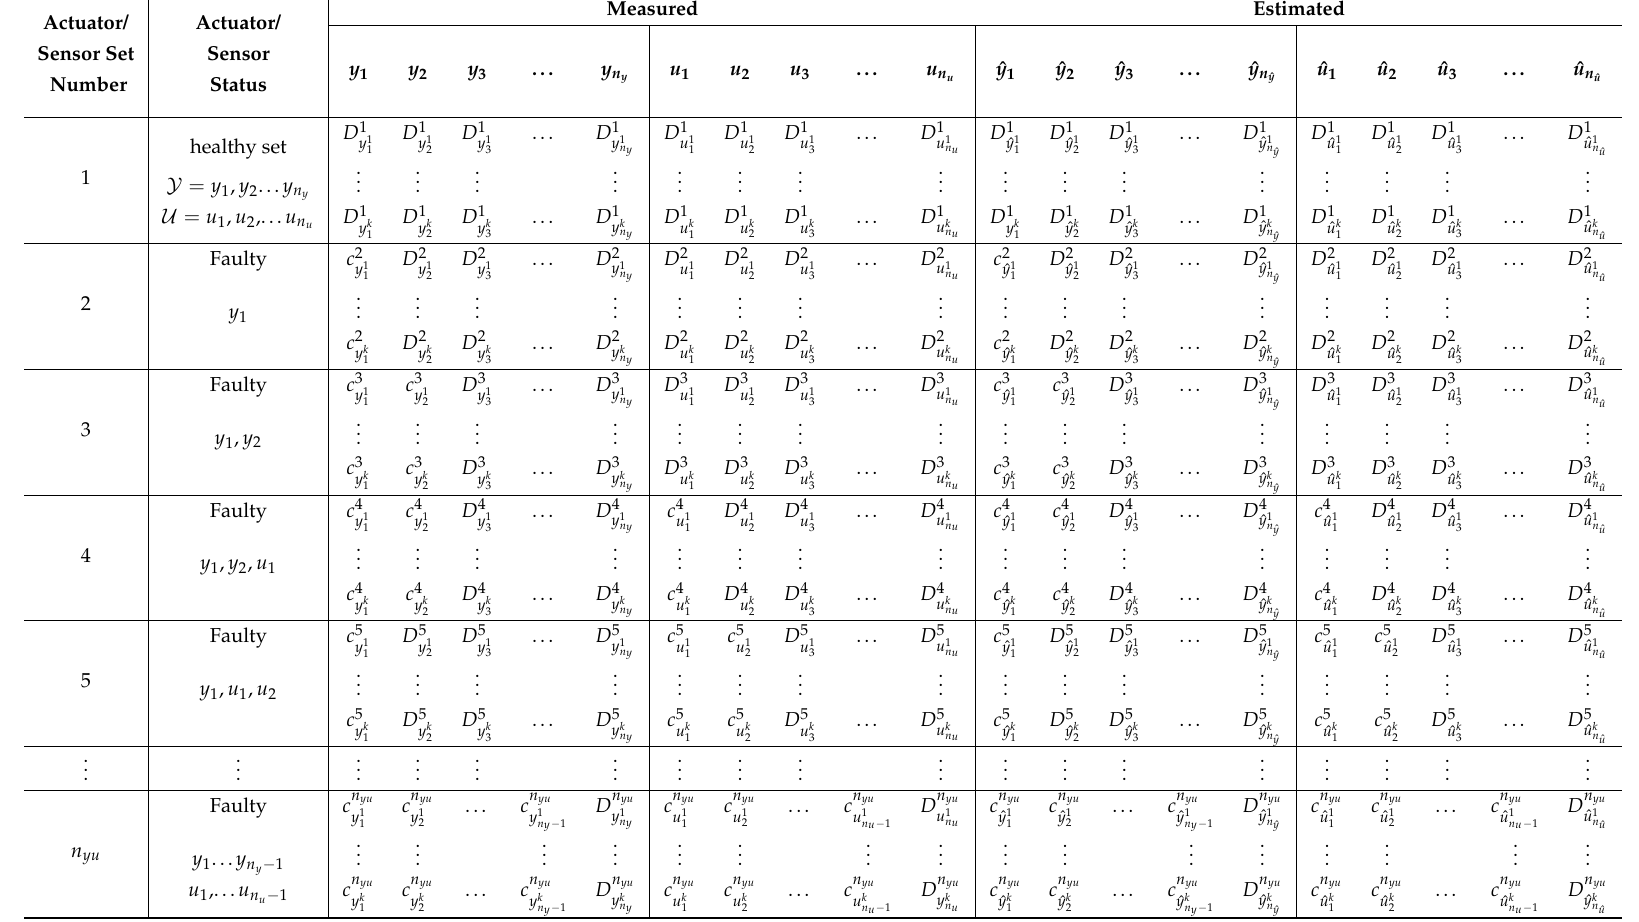
Table 1. Structure of the data used for the i FD training (basis from [19]). Measured Estimated Actuator/ y